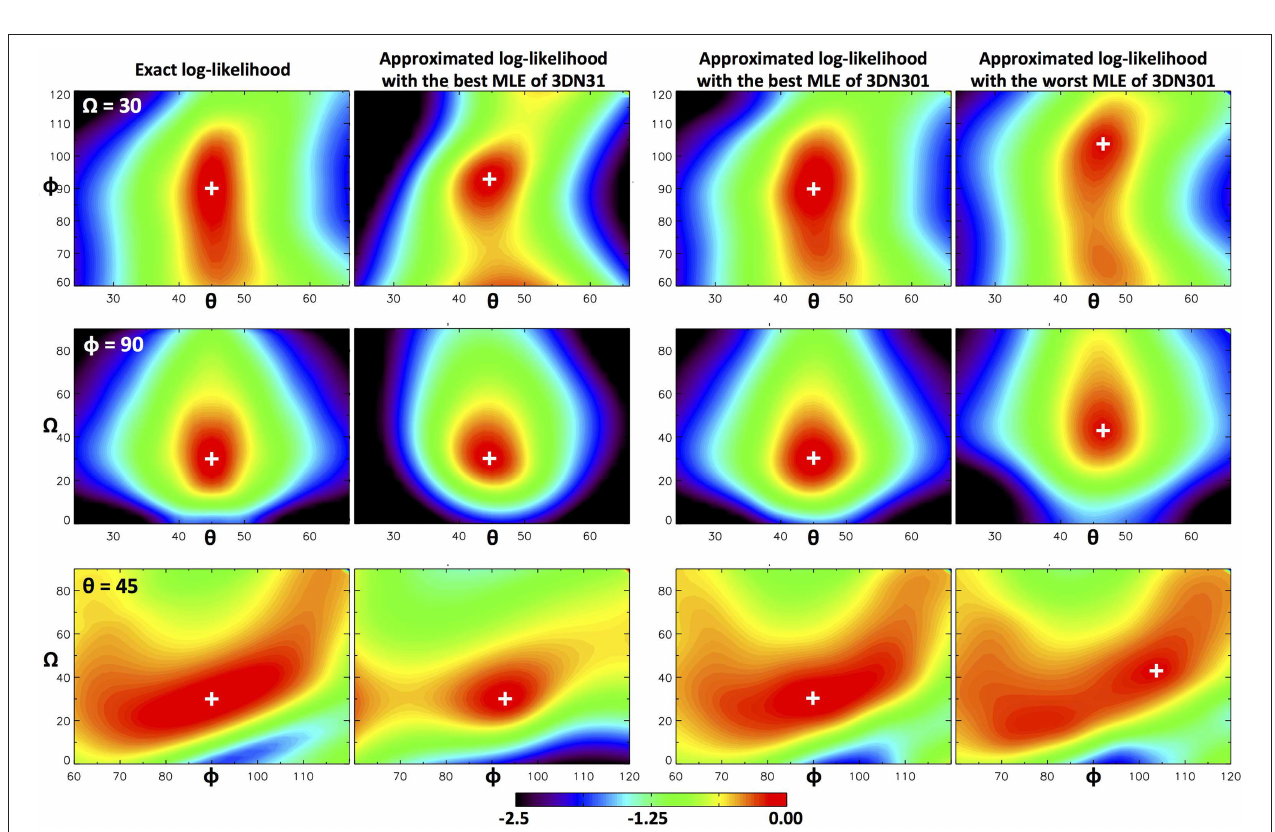
FIGURE 5 | Comparison between approximated and exact log-likelihood functions. The white “ + ” symbol indicates the position of the maximum log-likelihood.